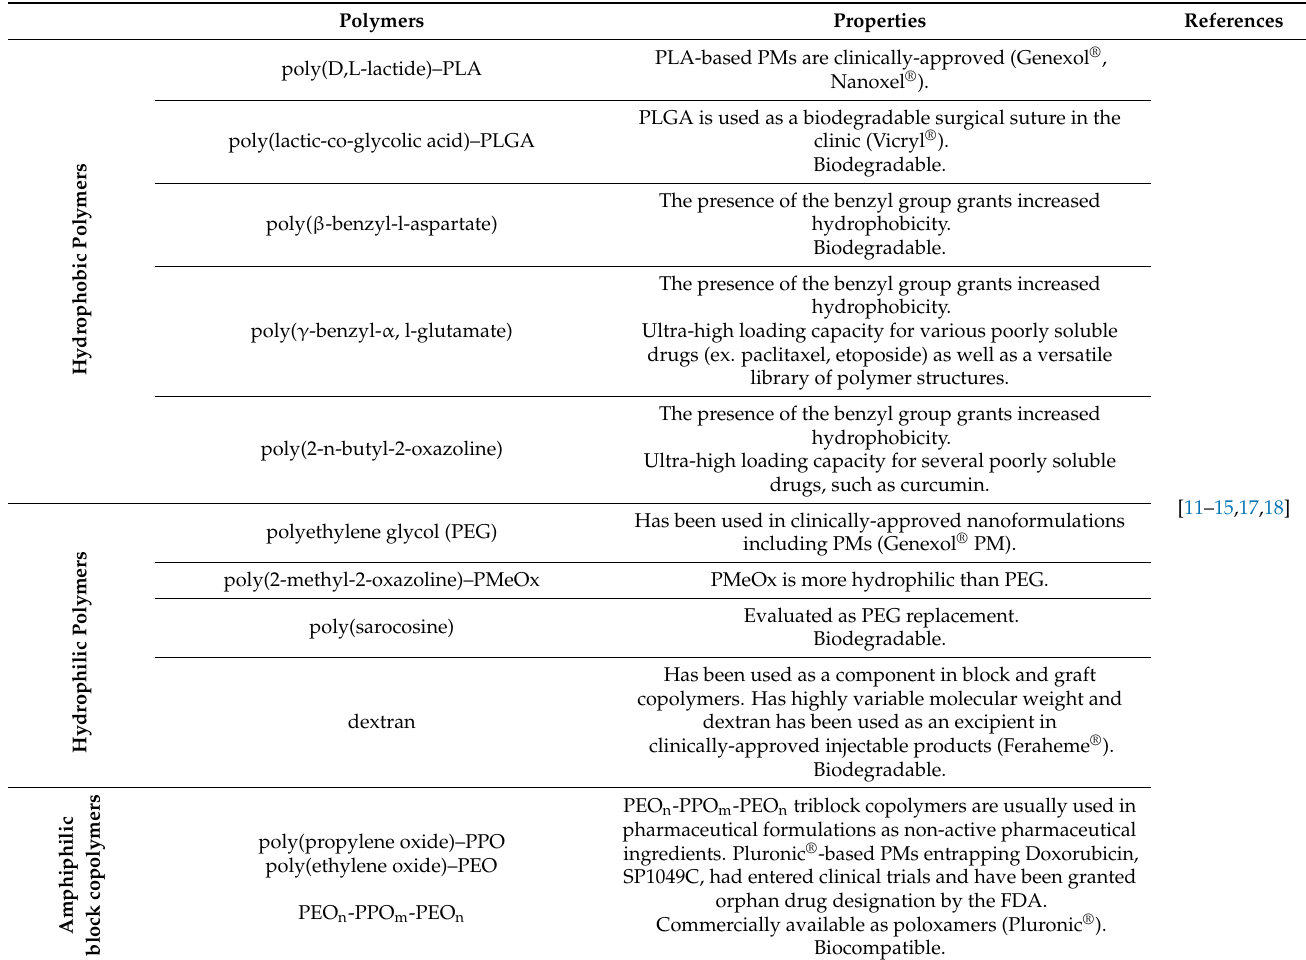
Table 1. Examples and respective properties of hydrophobic and hydrophilic polymers as well as amphiphilic block copolymers commonly used in the formulation of polymeric micelles. Polymers